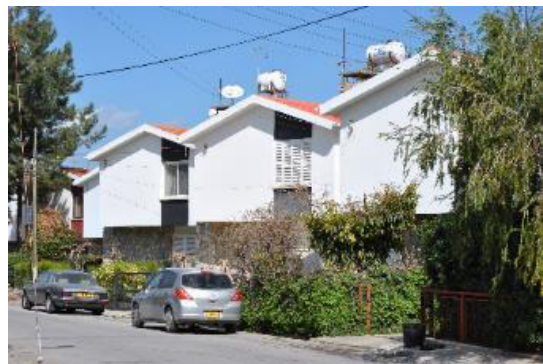
Figure 20. North Elevation of Efrus House (Image by Author, 2016)